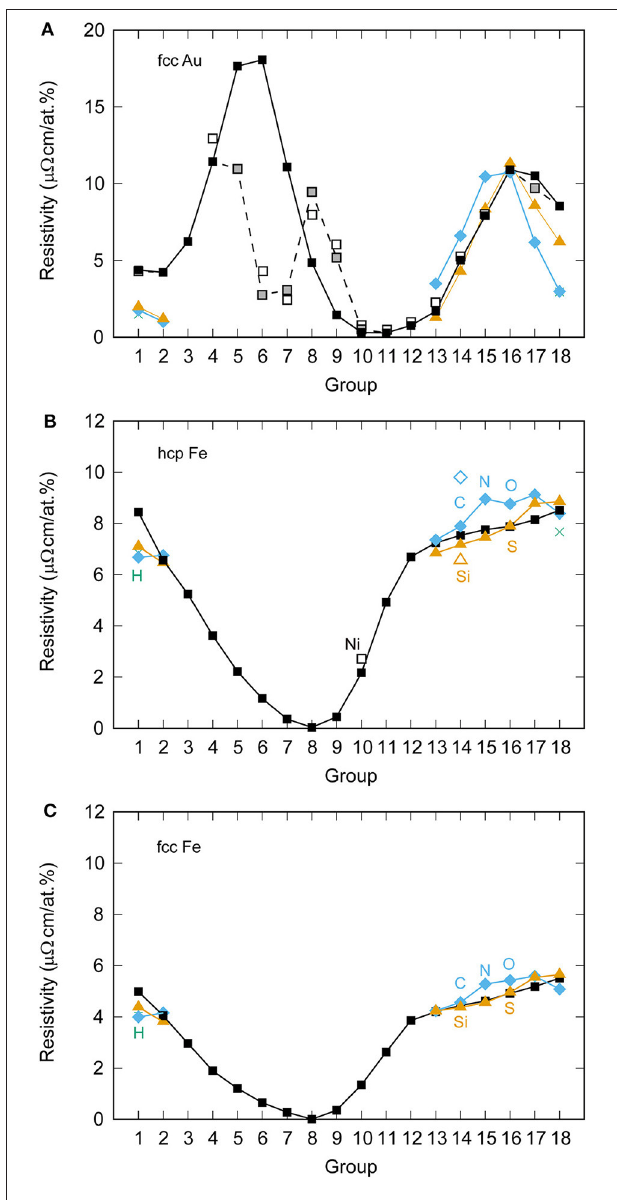
FIGURE 1 | Impurity resistivities of 1st (green cross; H and He), 2nd (blue diamond; Li, Be, B, C, N, O, F and Ne), 3rd (orange triangle; Na, Mg, Al, Si, P, S, Cl, and Ar) and 4th (black square; K, Ca, Sc, Ti, V, Cr, Mn, Fe, Co, Ni, Cu, Zn, Ga, Ge, As, Se, Br and Kr) period elements. (A) fcc Au-alloys at 1 bar compared with literature values (Friedel, 1956). (B) hcp Fe-alloys at 40 GPa compared with previous DAC experiments (Ni: Gomi and Hirose, 2015; Si: Gomi et al., 2016; C: Zhang et al., 2018). (C) fcc Fe-alloys at 40 GPa. In common, solid symbols with solid lines are present nonmagnetic calculations, gray square symbols with broken line are obtained from present LMD calculations and open symbols represent previous experiments.